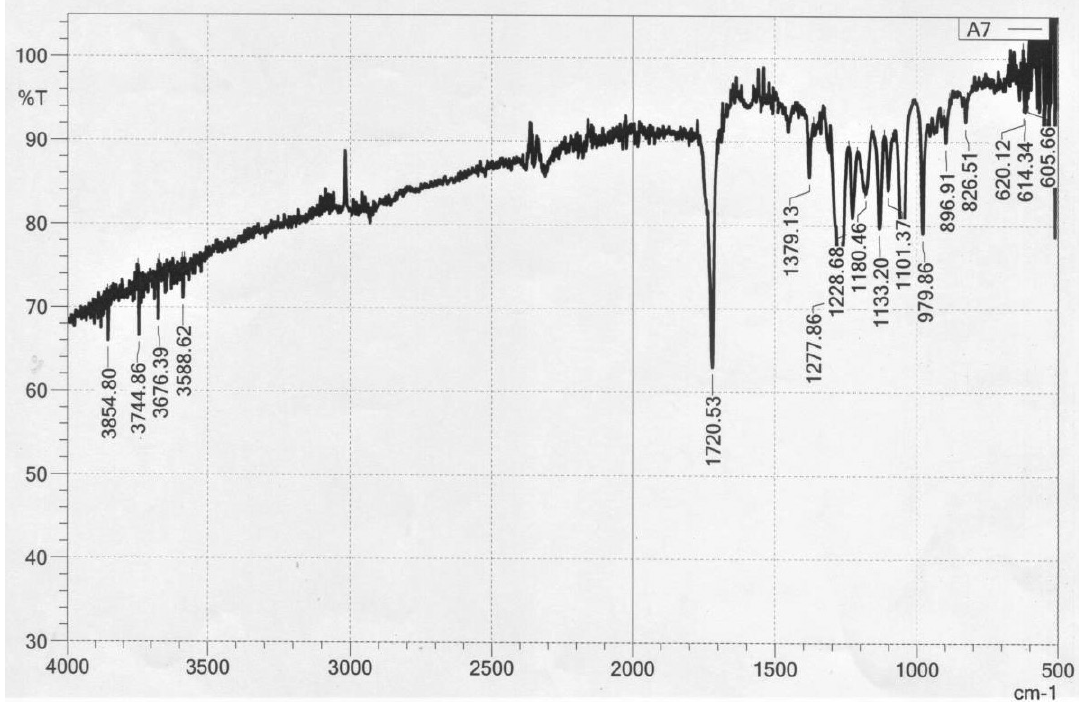
Figure 5: FTIR spectrum of PHA produced by strain PWC ( Pseudomonas aeruginosa ; MH142144) showing absorption band at 1720.53 cm −1 which is a reported PHA marker band (C=O bond).